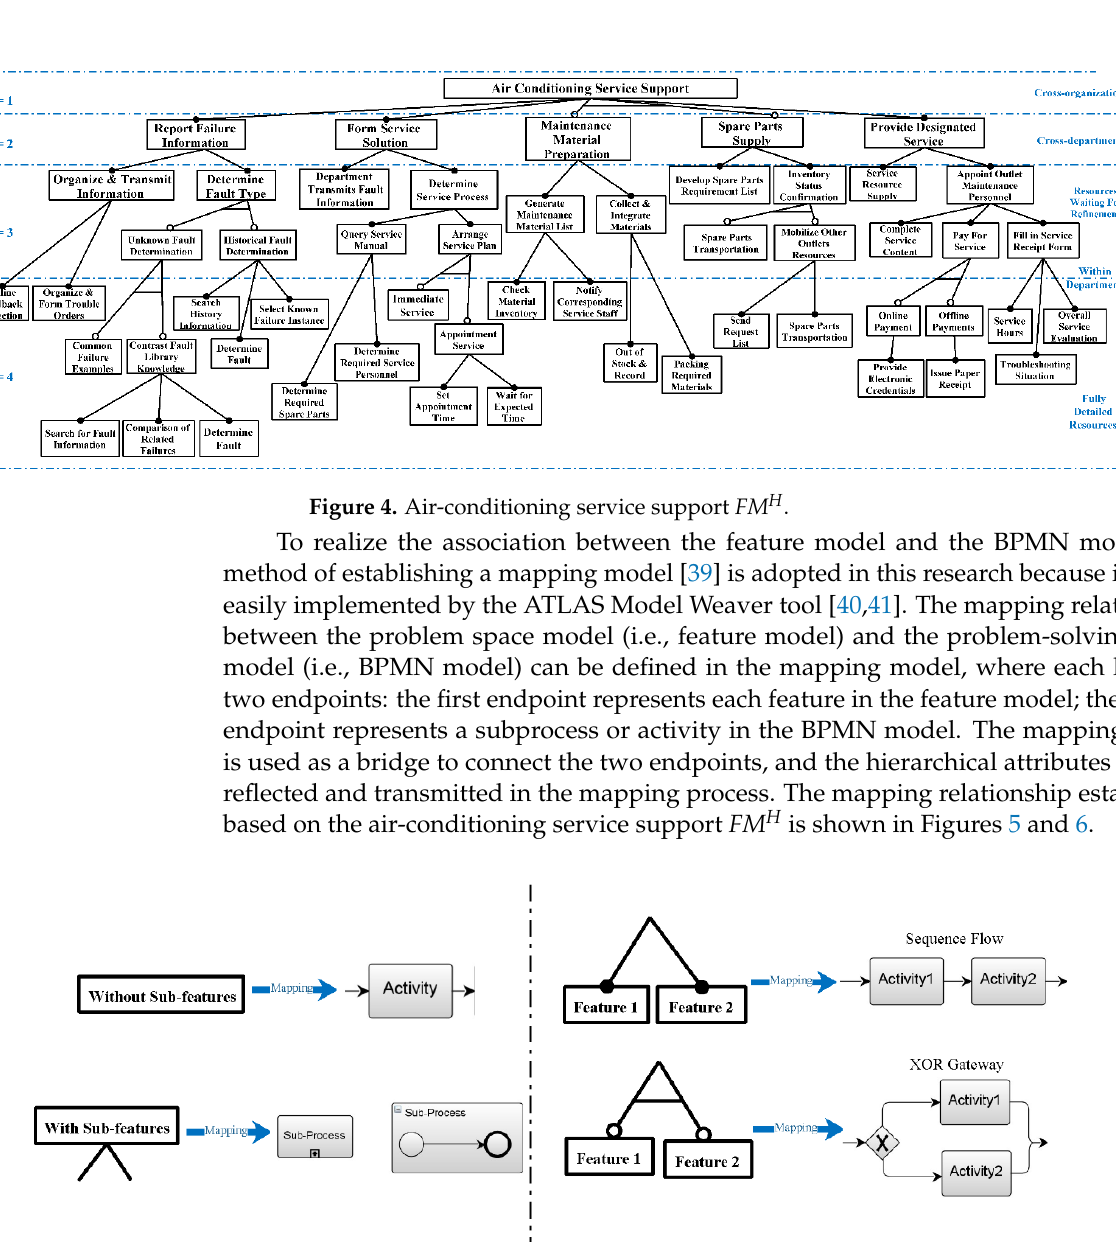
Figure 5. Mapping example.